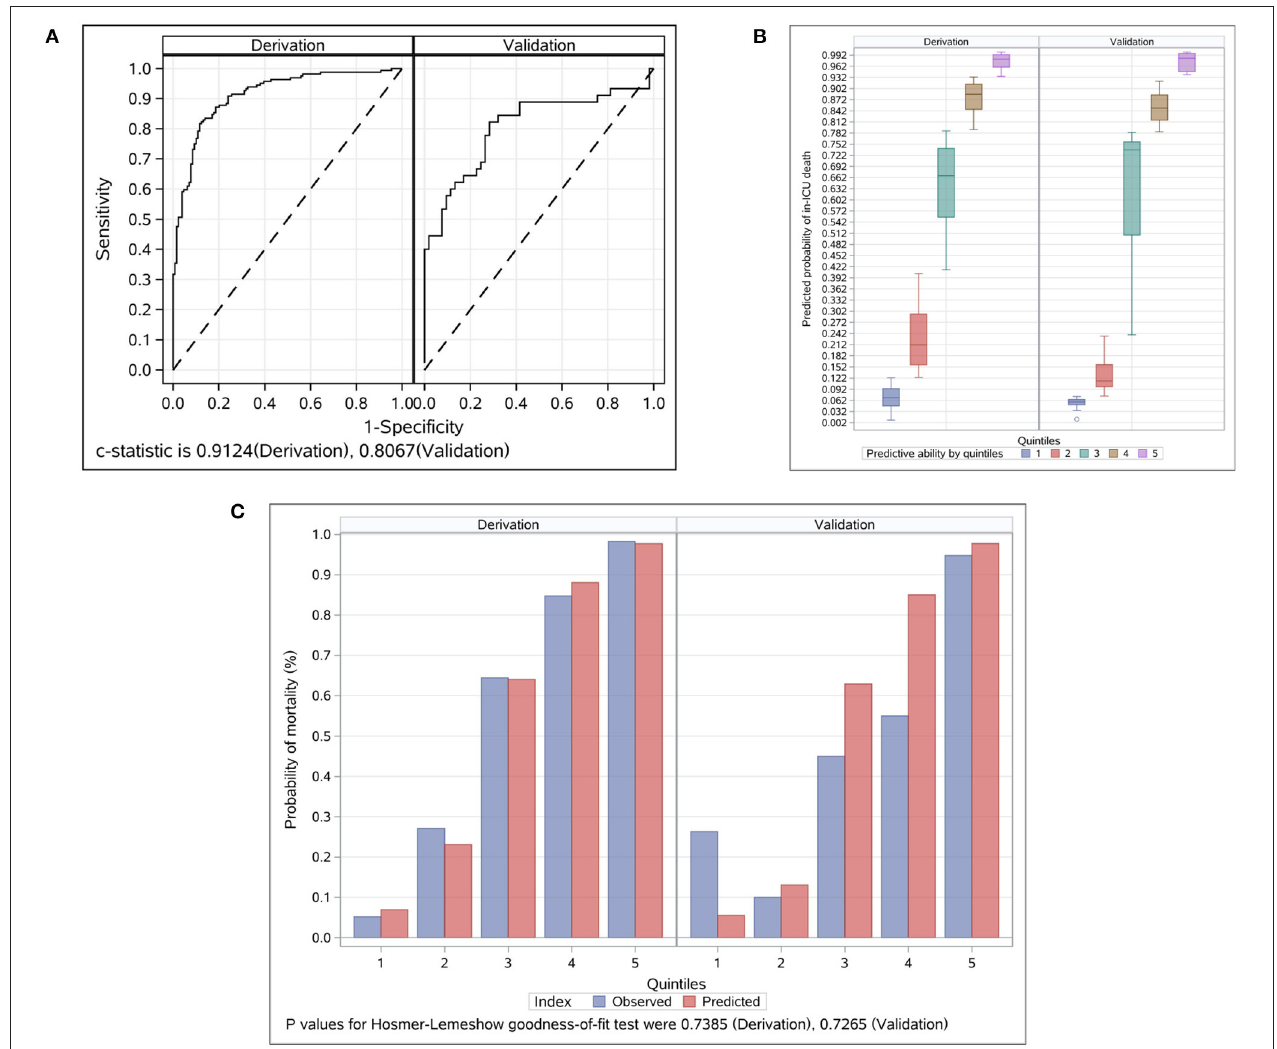
FIGURE 2 | Evaluation for the final prognostic model in the derivation and validation groups. (A) ROC analyses for the evaluation of the risk model in the derivation and validation groups. Model performance in the validation group was comparable to that in the derivation group. The overall C Statistic was 0.912 (95% CI, 0.889–0.948) and 0.807 (95% CI 0.703–0.889) for the derivation and validation groups, respectively. (B) Probability of in-ICU death events by quintiles in the derivation and validation groups. Patients in each group were divided into five classes based on the nine prognostic factors. The mean observed in-ICU mortality ranges was from 5.2 to 98.3% for the derivation group, and from 6.3 to 94.7% for the validation group, respectively. (C) Observed vs. predicted values by quintiles in the derivation and validation groups. The P -value of the Hosmer and Lemeshow goodness-of-fit test was 0.7385 and 0.7265 for the derivation and validation groups, respectively. ICU, intensive care